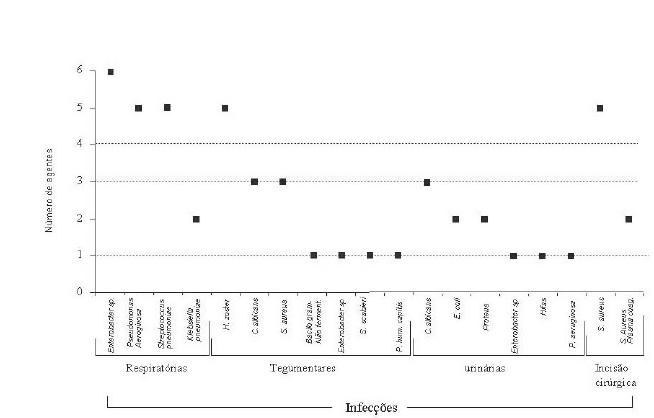
Fig. 1 - Distribuição dos agentes etiológicos causadores de infecções associados às principais